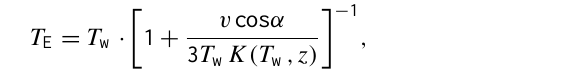
Table 8. Parameters of the environmental fields. θ w bound directions, increasing clockwise; α creasing clockwise; see Fig.